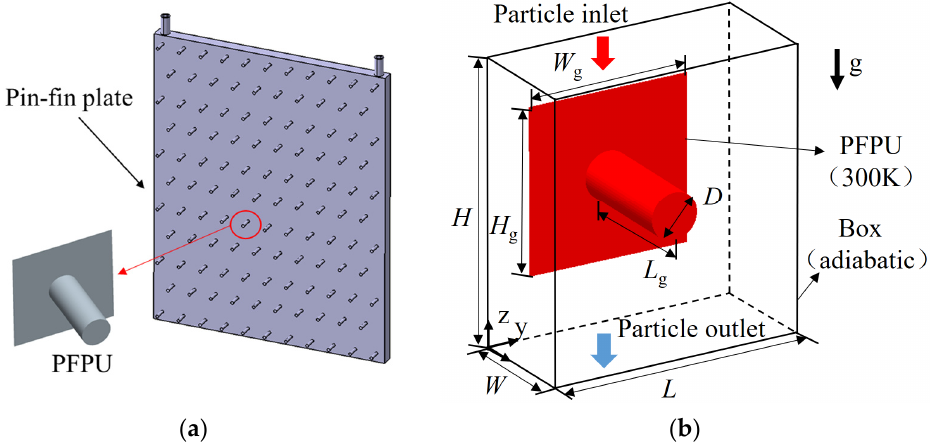
Figure 3. Schematic diagram: ( a ) PFPU; and ( b ) geometry model. Table 1. Geometric and physical parameters in simulation. During the simulation, the temperature of the PFPU is kept constant at 300 K and the channel wall is adiabatic. The particles with the temperature of 700 K are generated at the inlet of the channel and continuously flow into the channel to ensure the dense filling of particles in the channel. The particle velocity is controlled at the outlet of the channel and keeps constant at − 1 mm/s in the Z direction. The parameters related to the calculated motion of particle to particle and particle to wall are shown in Table 2. The whole simulation lasts for 41 s, and the heat Q is analyzed in the last 10 s. The calculation equation for the heat transfer coefficient k of particle flow around PFPU is shown in Equation (5). Q is the total heat between particles and PFPU; A PFPU is the heat transfer area of PFPU; T in is the inlet temperature of particles; T PFPU is PFPU wall temperature; and t is time.